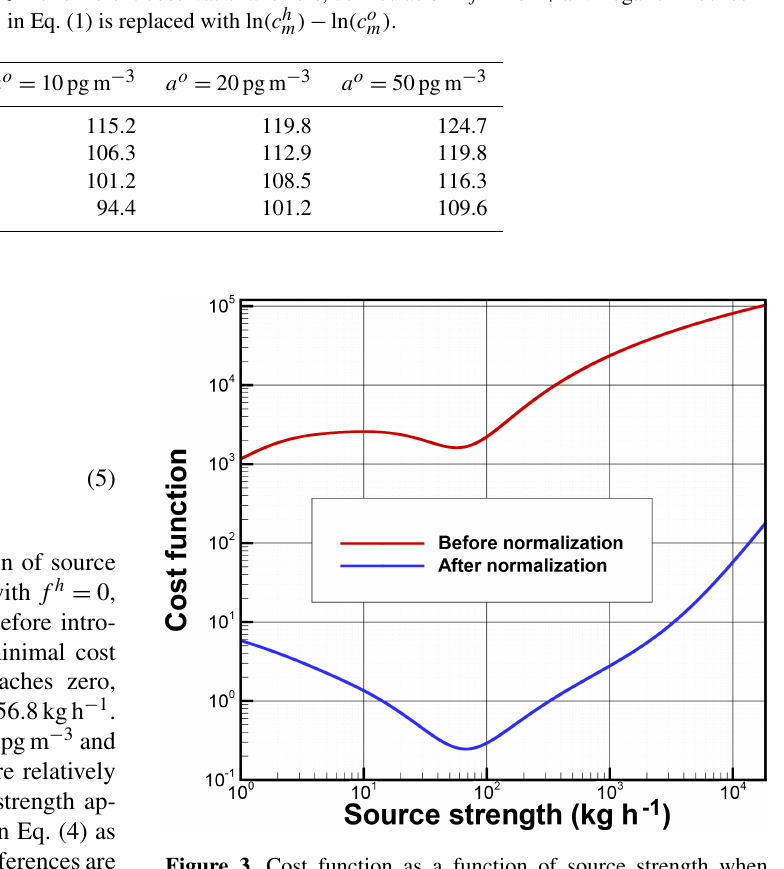
Figure 3. Cost function as a function of source strength when ((cid:15) ln (c) m ) 2 is defined as in Eq. (4) before and after cost function nor- malization, with f h = 0, a h = 50pgm − 3 , f o = 10%, and a o = 20pgm − 3